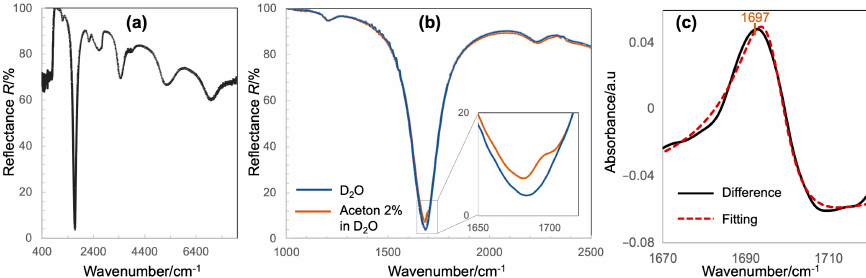
Figure 3. ( a ) Typical reflectance spectrum of the IR-compatible nanofluidic device integrated with MIM perfect absorber metamaterial, ( b ) reflectance spectra when the device is filled with D 2 O and acetone/D 2 O, respectively revealing the IR absorption signal of C ═ O, and ( c ) the Fano line-shape fitting of the difference spectrum for retrieving the intrinsic IR absorption of C ═ O.